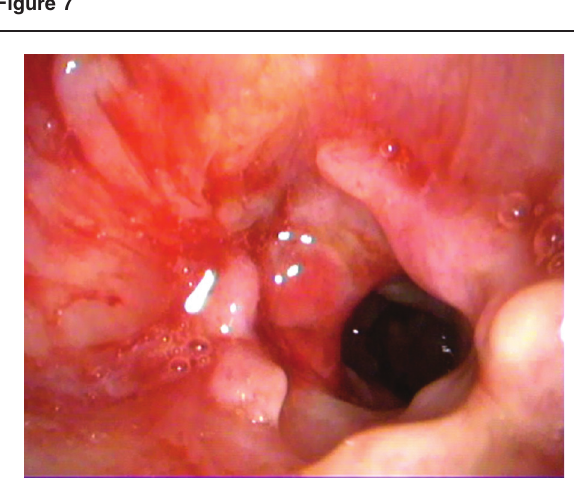
Bronchoscopic view showing recurrent stenosis and granulations.